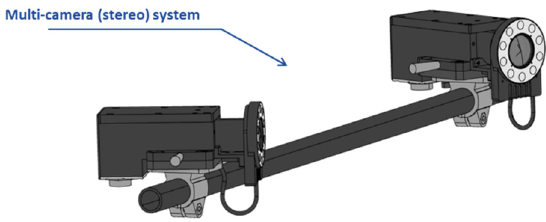
Figure 3. The multi-camera system under study is a stereo-photogrammetric device. Each camera is composed by an industrial camera, lens, and LED illumination. All of this is encapsulated in a housing to avoid noisy environments.